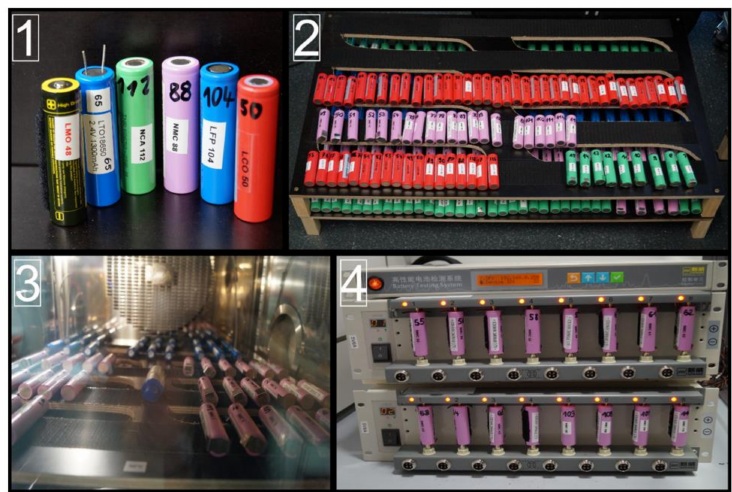
Figure 2. Panel 1: Selected cylindrical cells for the investigation; Panel 2: Wooden shelf construct for storage in climate chambers; Panel 3: Cells in climate chamber, including an additional temper- ature recorder (ELV USB-Datalogger UTDL10); Panel 4: Cells in four-wire clamps during capacity verification in